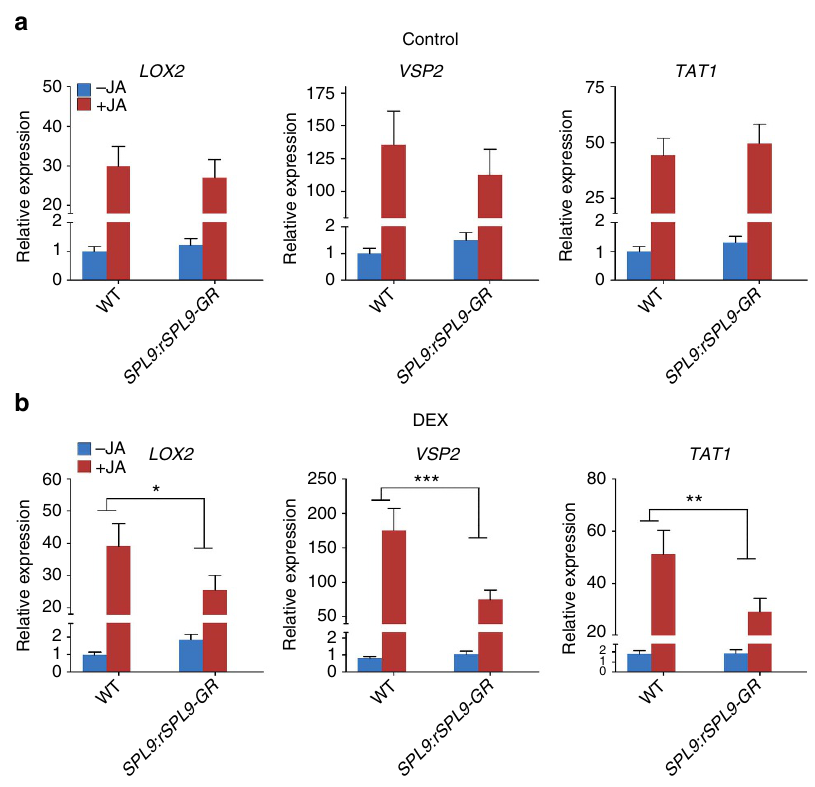
Figure 3 | Translocation of SPL9 into nucleus by DEX treatment dampens JA response. The wild-type and SPL9:rSPL9-GR plants (12D in LD) were first sprayed with ethanol (control) ( a ) or 10 m M DEX ( b ), and after 12h the plants were treated with 50 m M MeJA ( þ JA) or ethanol ( (cid:2) JA). Four hours later the transcript levels in the first pair of leaves were detected by qRT-PCR. The expression in the wild-type free from DEX and JA was set to 1. Data were analysed by multiple comparisons (Tukey test) followed by two-way ANOVA (* P o 0.05, ** P r 0.01, *** P r 0.001). Error bars represent ± s.d. ( n ¼ 3). ANOVA, analysis of variance.